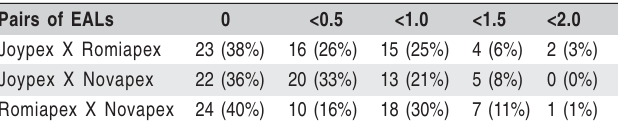
Table 2. Absolute difference distribution of working length measurements by different pairs of electronic apex locators